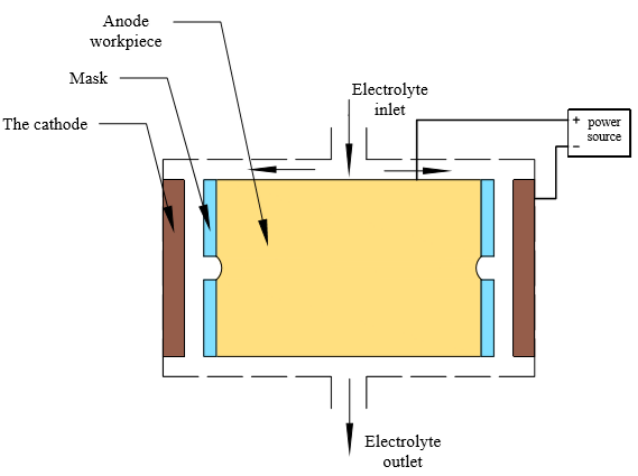
Figure 1. S chematic diagram of mask electrochemical machining of annular narrow